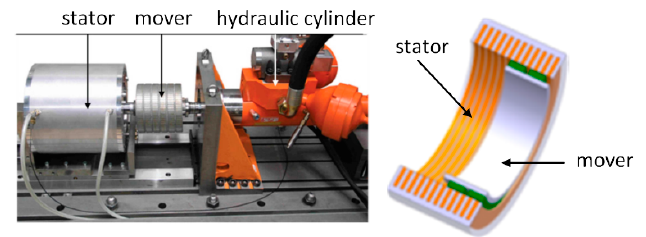
Figure 13. First generation linear generator of DLR [22].